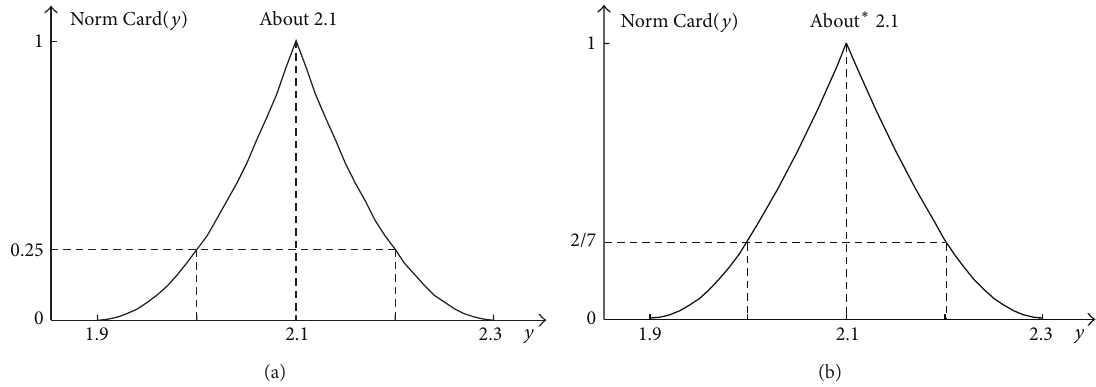
Figure 15: 2D representation of the full 4D result in a form of the cardinality distribution for the case of the addition of two independent fuzzy numbers (a) and for the case of the addition of two fuzzy numbers constrained by the order relation 𝑥 2 > 𝑥 1 (b).